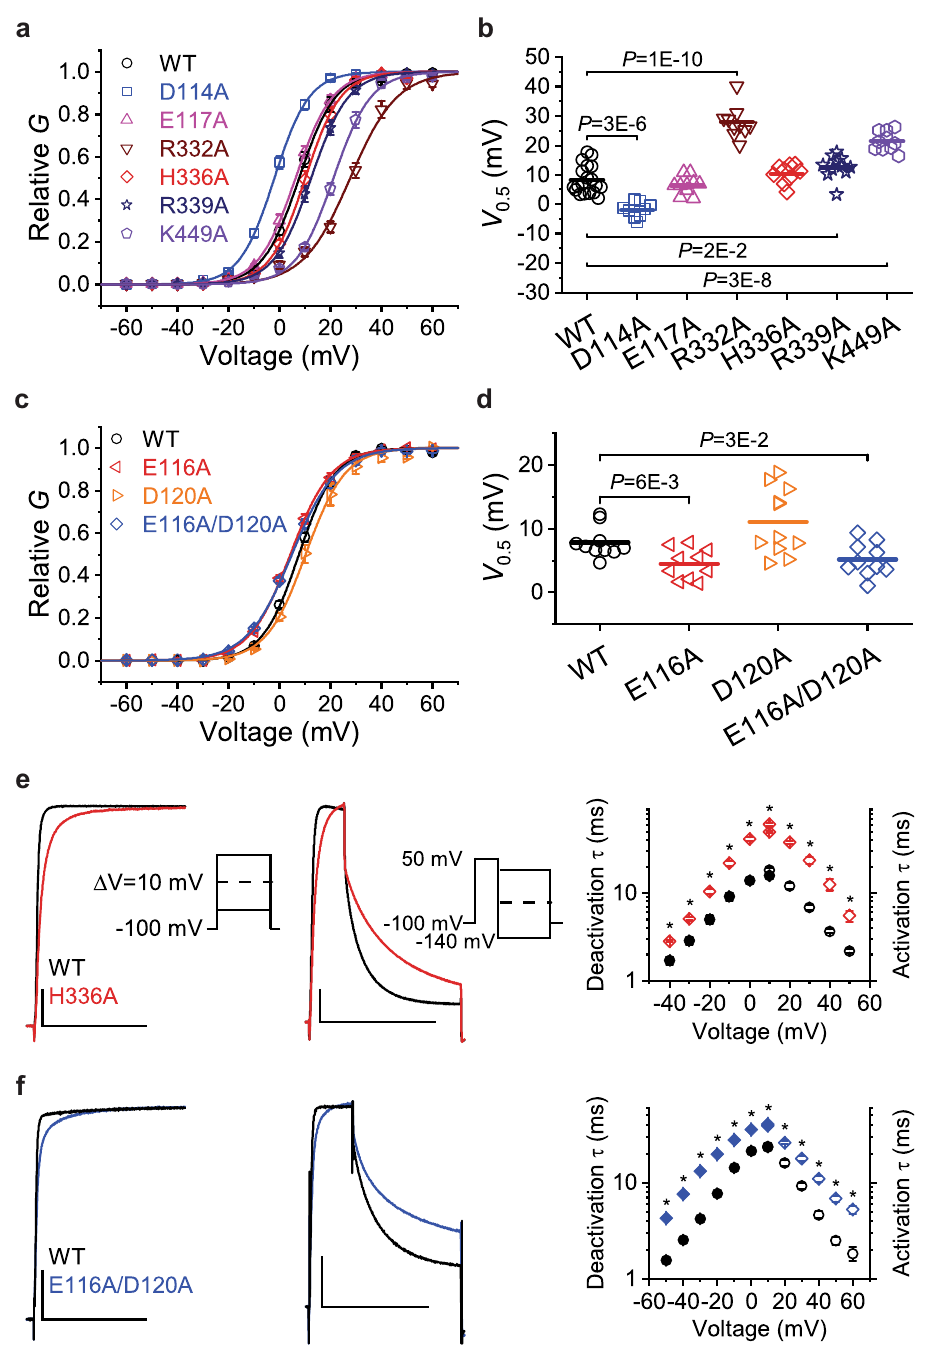
The mutation is situated at a mechanistically important position and interrupts polar interactions with several backbone carbonyl oxygens in the α 6 helix (Fig. 4c). In the AlphaFold2 model, H336 interacts with the side chain and the backbone carbonyl of S121 at the algorithm (Fig. S8b, d). This might be a consequence of the